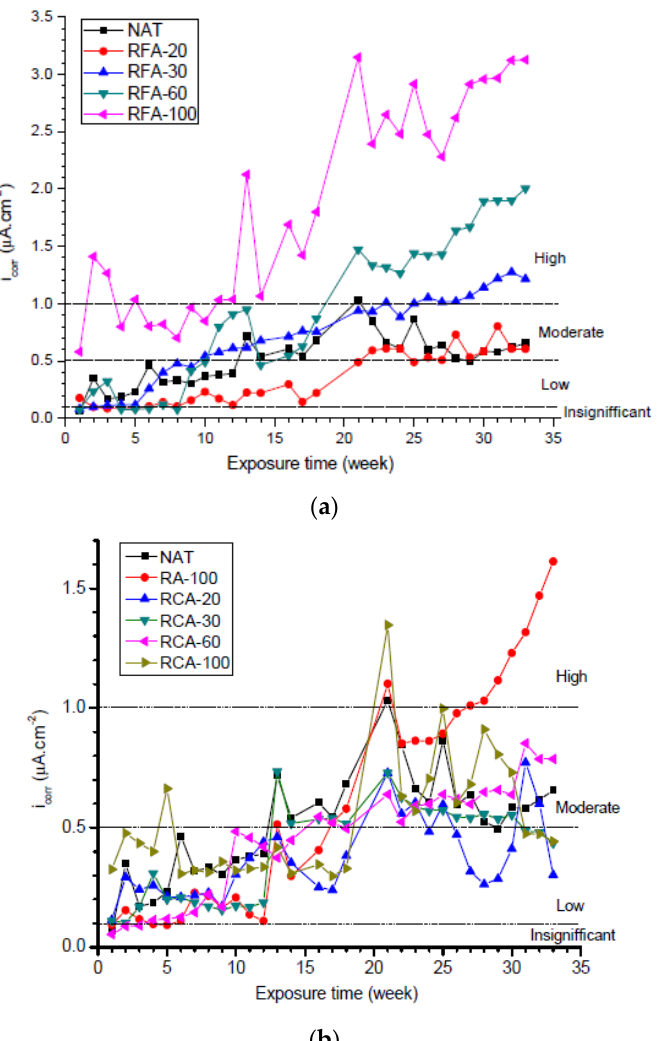
Figure 2. Effect of RAs on the corrosion rate of reinforced concrete exposed to wetting and drying cycles in 35 g/L NaCl solution for: ( a ) fine RA and ( b ) coarse RA. NAT is the control concrete, and RFA (fine) and RCA (coarse) are concretes with RA. The numbers indicate the percentage replacement ratio, and RA-100 is concrete with 100% content of both fine and coarse RA. Reprinted with permission from Ref. [64]. 2019, MDPI.